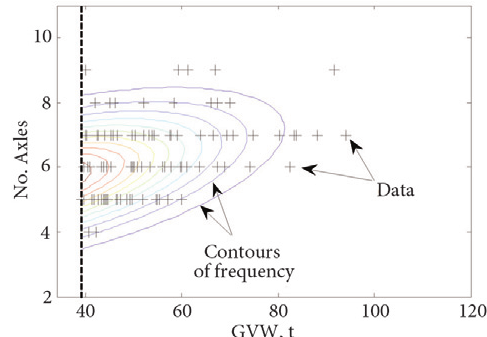
Fig. 5. The tail of a bivariate Normal distribution fitted to gross vehicle weight (GVW) and numbers of axles, for low loaders above a certain weight threshold at the Poland WIM